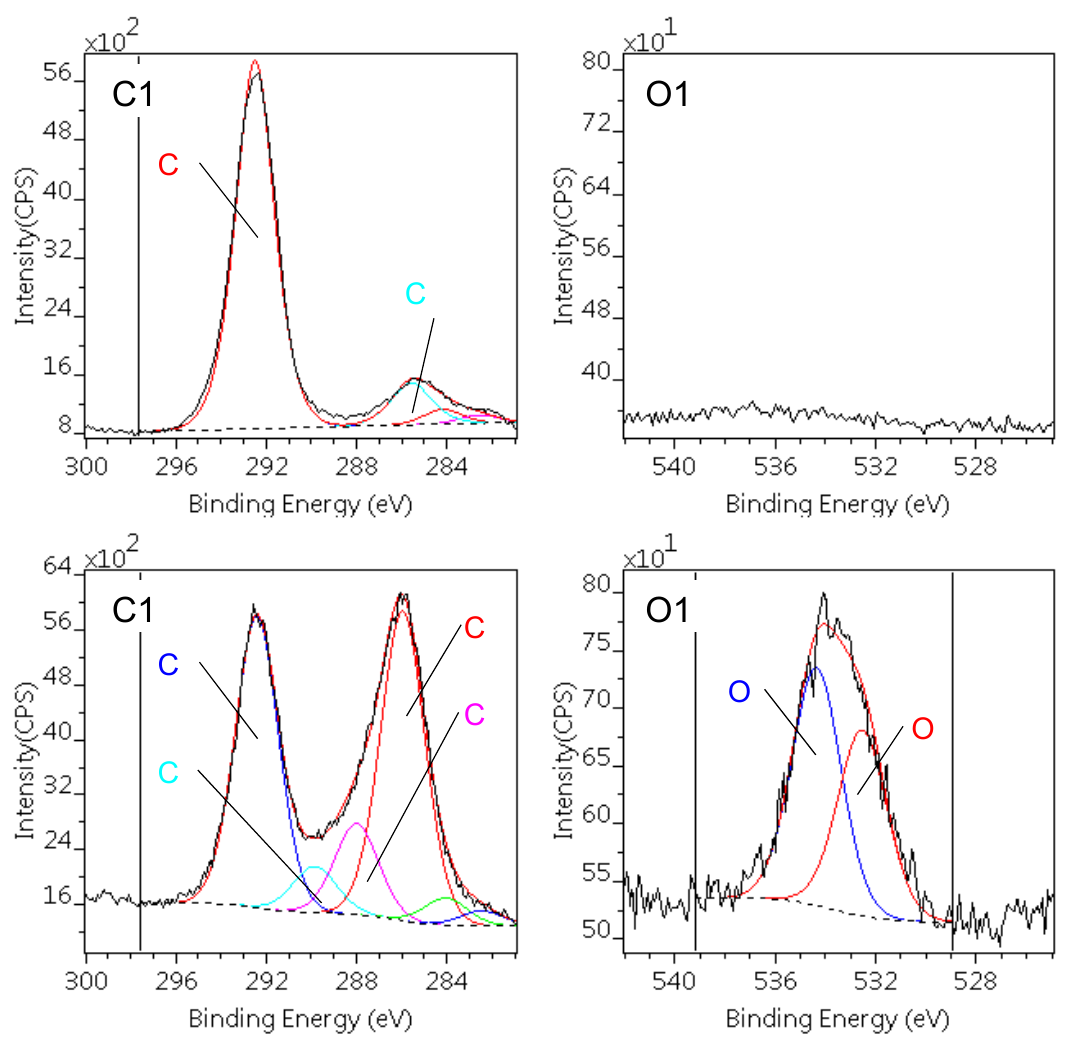
Figure 3. C1s and O1s photoelectron spectra of the pristine (upper) and DCSBD treated (lower) PTFE sample (unmarked C1s components are X-ray satellites).